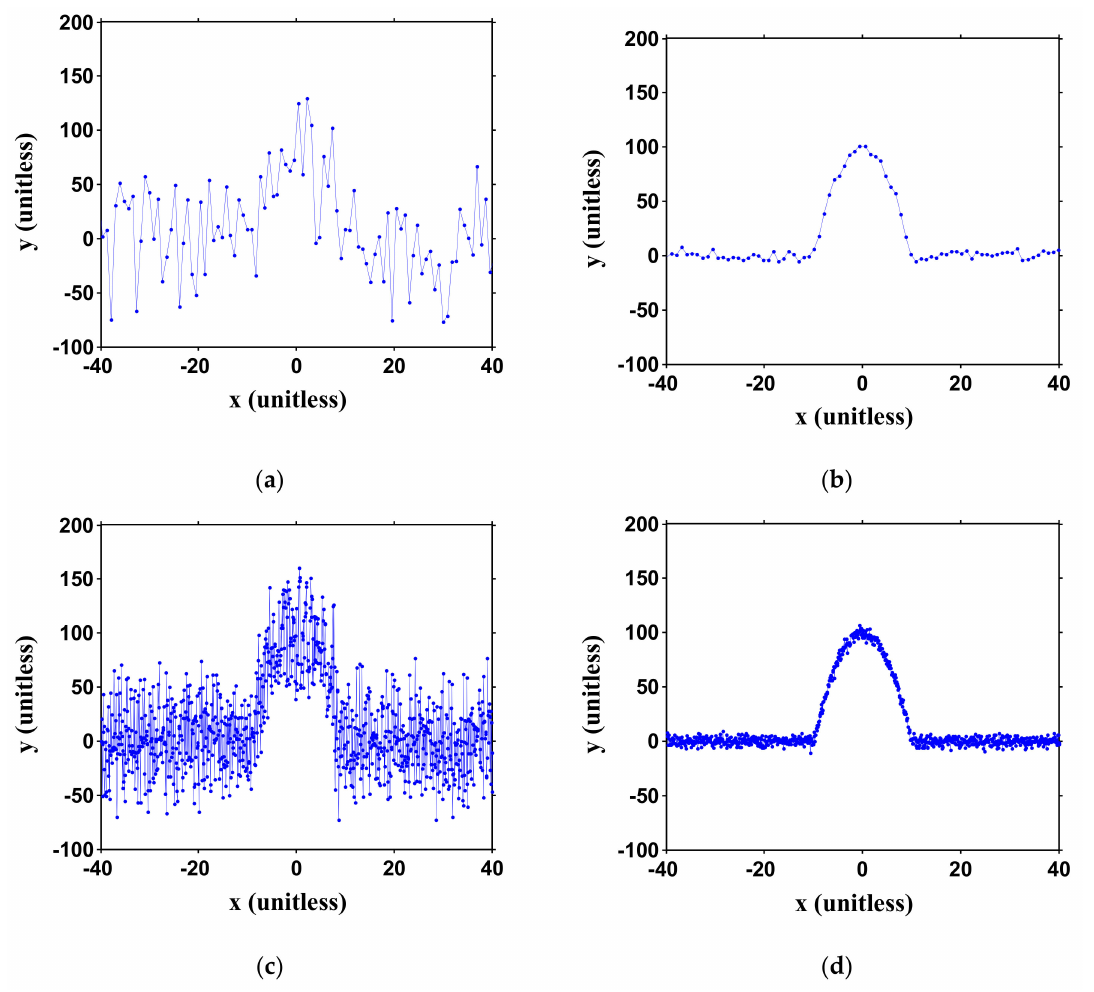
Figure 3. Emulated captured curves under different conditions. (The ideal curve above the noise level is set as y = − x 2 + 100). Left column ( a , c ): signal-to-noise ratio (SNR) = 10 dB; right column ( b , d ): SNR = 30 dB; top row ( a , b ): N p = 20; bottom row ( c , d ): N p = 200. N p : number of points within the parabolic curve. Curves are unitless as illustrated in Figure